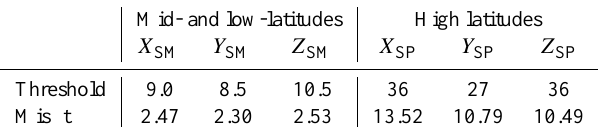
Mid- and low-latitudes High latitudes X SM X SP Y